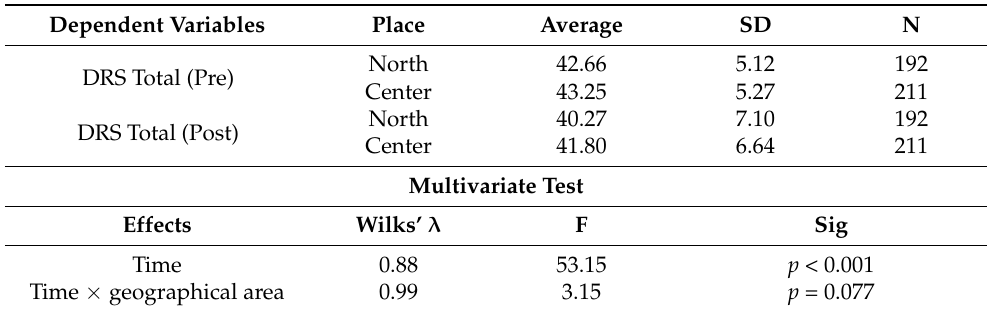
Table 14. Repeated measures ANOVA model of time (i.e., pre- and post-pandemic first-wave effect) and geographical area effects on hardiness.